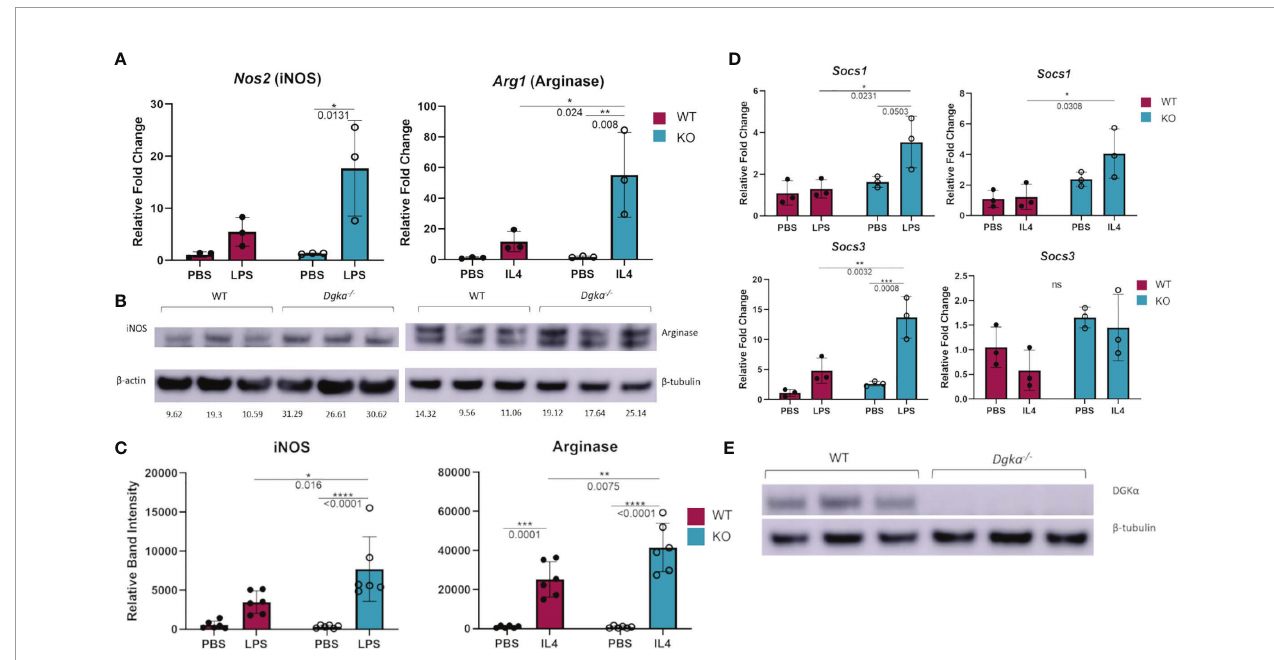
FIGURE 1 | Increased expression of macrophage activation markers in Dgka -/- BMDM following LPS or IL4 stimulation. (A) WT and Dgka -/- BMDMs were treated with 500ng/mL LPS or 2ng/mL IL-4 for 24h and assessed by qPCR for changes in Nos2 and Arg1 expression, respectively. (B) Immunoblot depicting protein expression of iNOS in lysates of LPS treated WT and Dgka -/- BMDMs (left) and arginase expression of IL-4 treated BMDMs. Quanti fi cation of band intensity normalized to PBS treated WT mice (not shown) are indicated in text below bands. (C) Summary plot depicting quanti fi cation of immunoblot band intensity of two independent experiments as in (B) for n = 6 per group. (D) WT and Dgka -/- BMDMs treated with LPS and IL-4 were assessed by qPCR for expression of SOCS1 and SOCS3. In (A – D) samples were normalized to the PBS treated WT control. (E) immunoblot of WT and Dgka -/- BMDM whole cell lysates with anti-DGK a antibody. Each data point represents an individual mouse for n = 3 per group. Error bars: SD. *p < 0.05, **p < 0.01, ***p < 0.001, ****p < 0.0001; ns, not signi fi cant; Two-way ANOVA with Tukey post-hoc